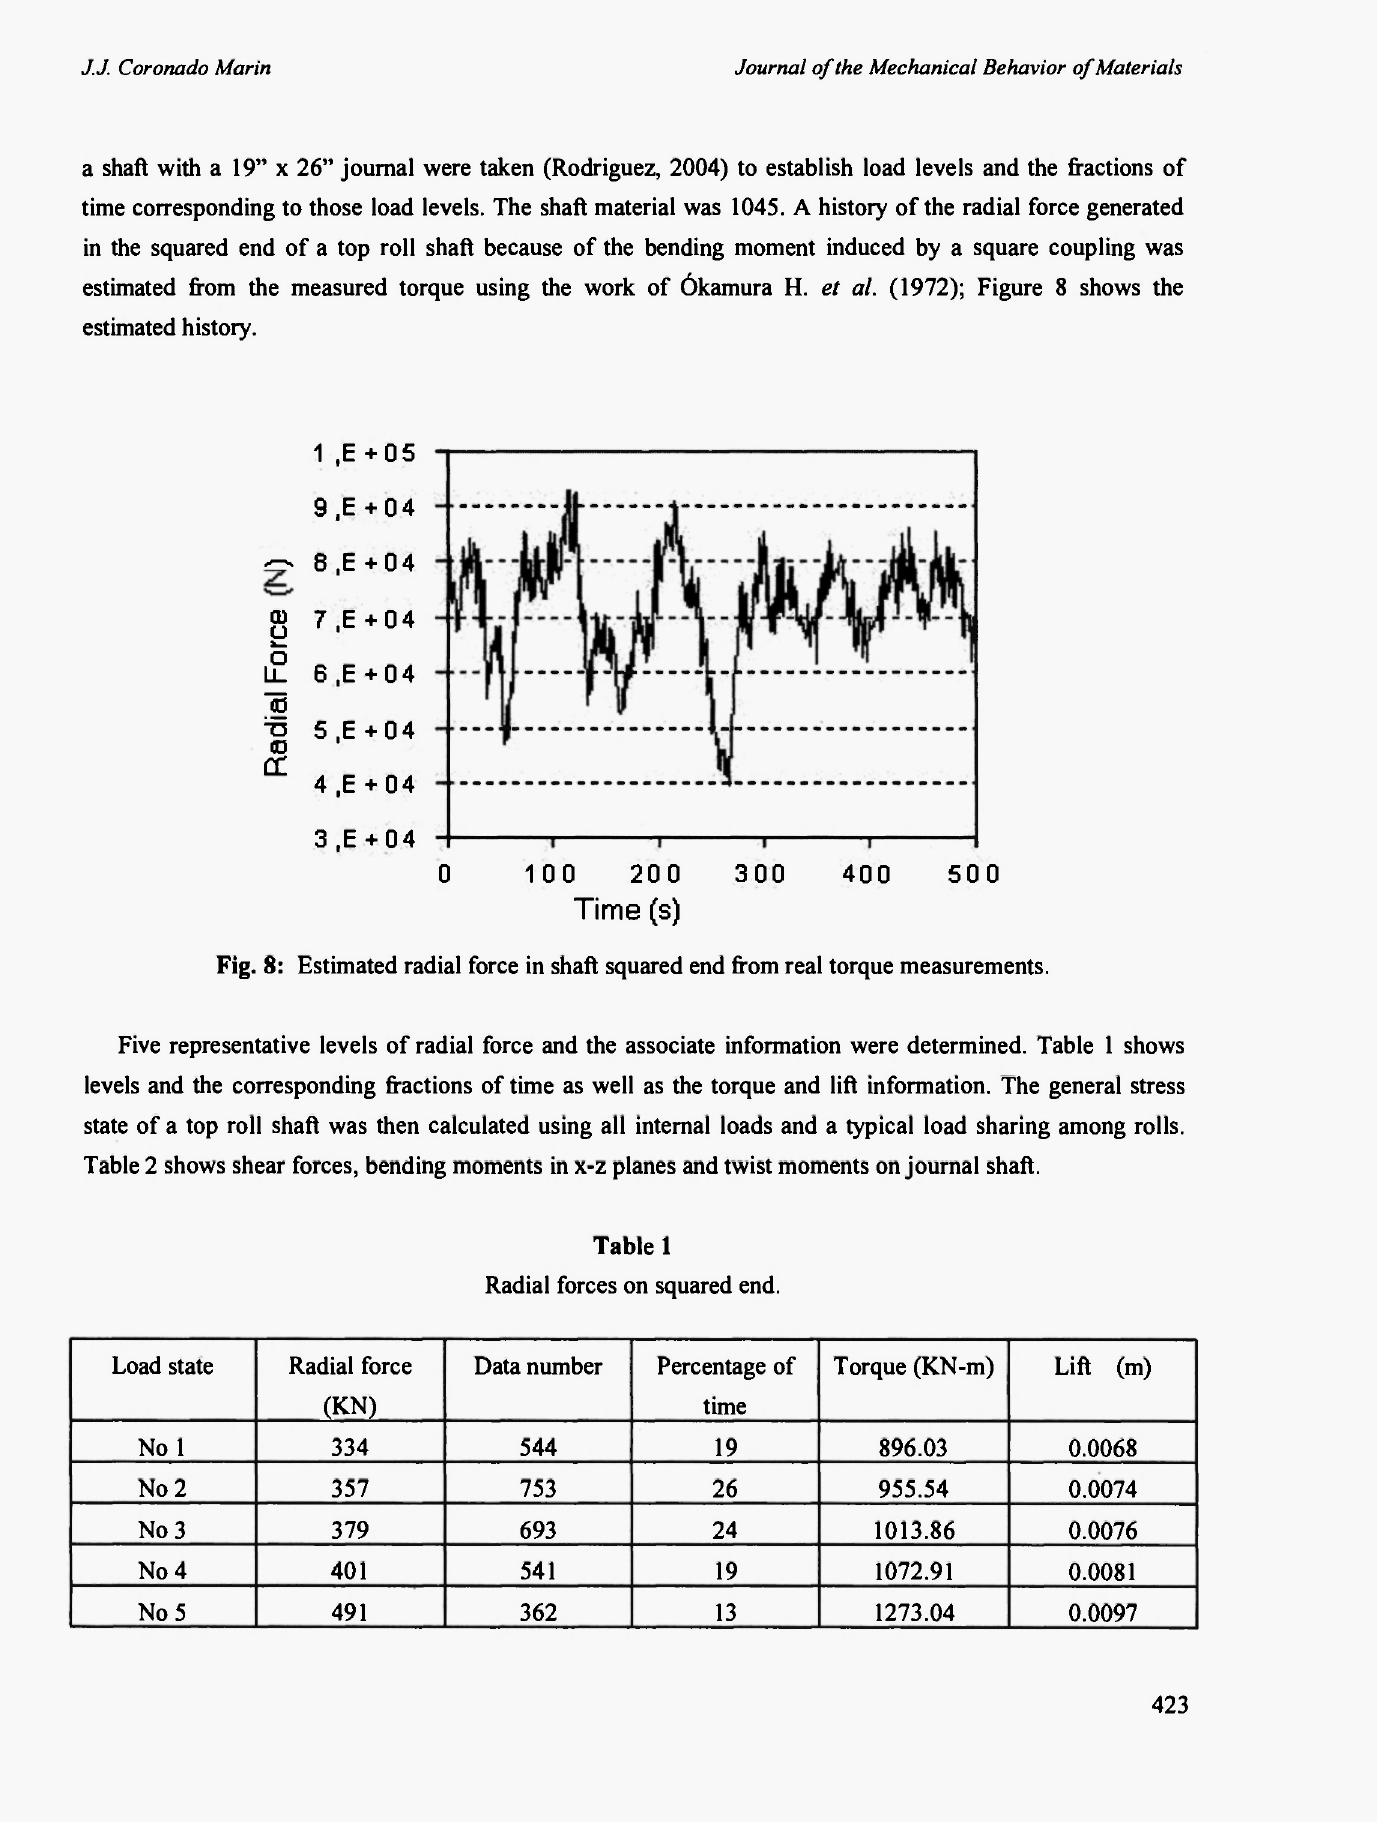
Fig. 8: Estimated radial force in shaft squared end from real torque measurements.